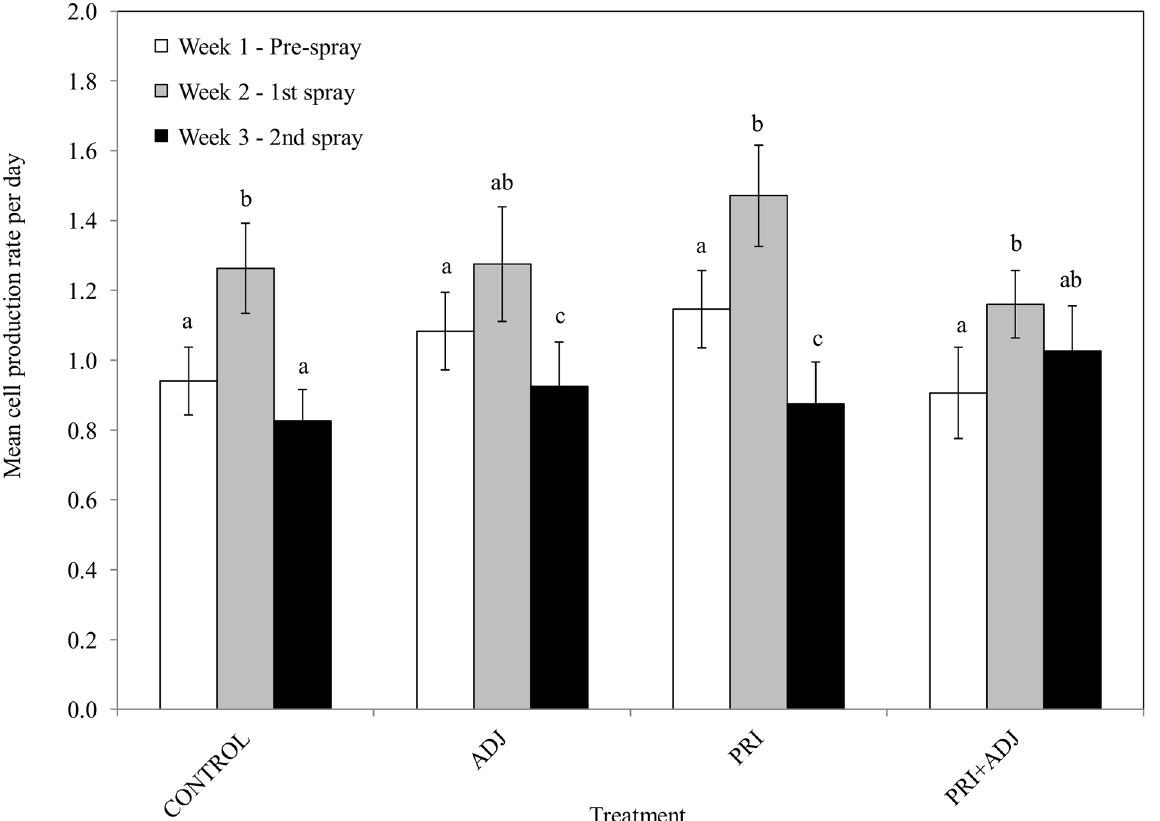
Fig 4. Mean cell production rate per day by Megachile rotundata females before and after treatment applications. Means within each treatment with different letters are significantly different ( P <